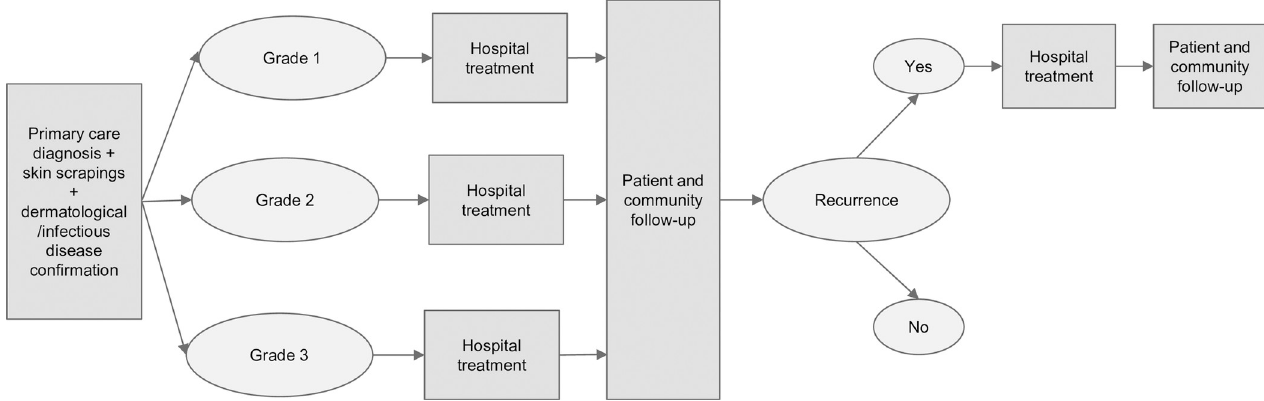
Fig 1. Assessment, treatment, follow-up and recurrence phases of the COI model for CS.